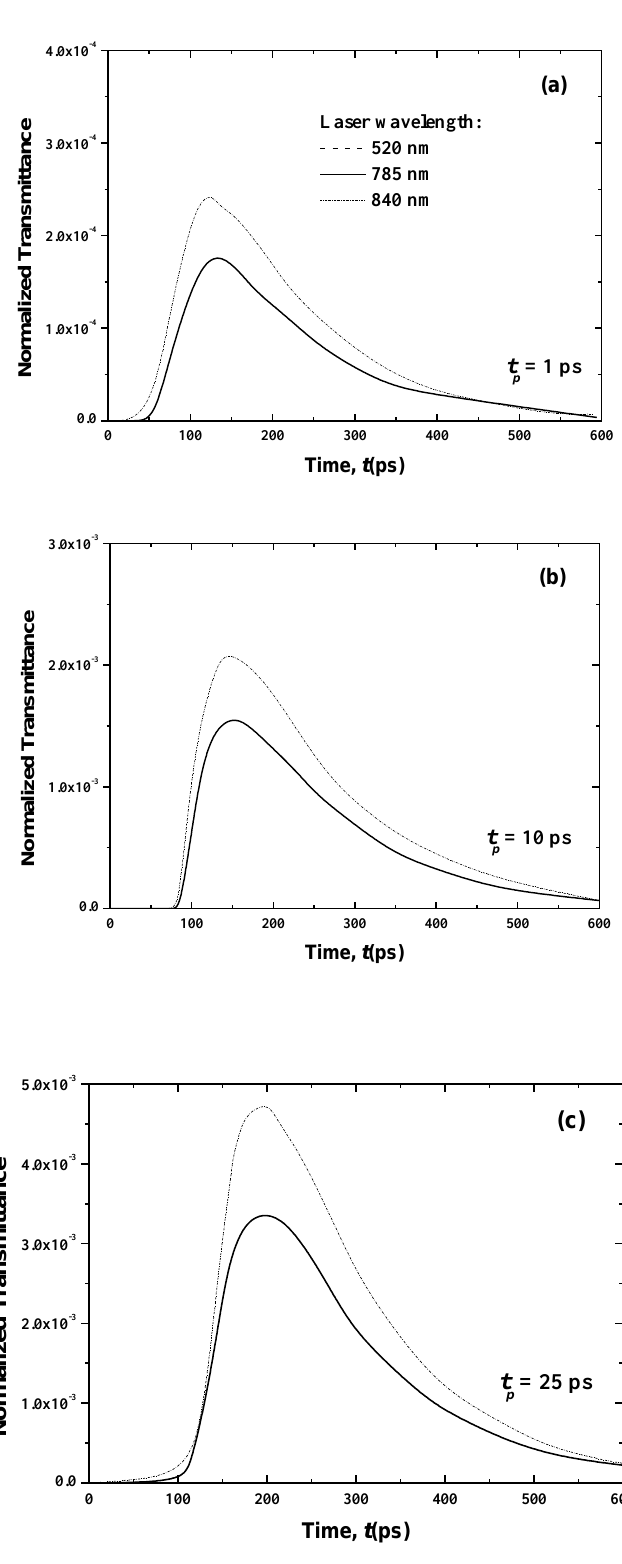
Figure 8. Temporal signals of the normalized transmittance from the normal skin at different laser pulse widths of ( a ) 1 ps, ( b ) 10 ps and ( c ) 25 ps.